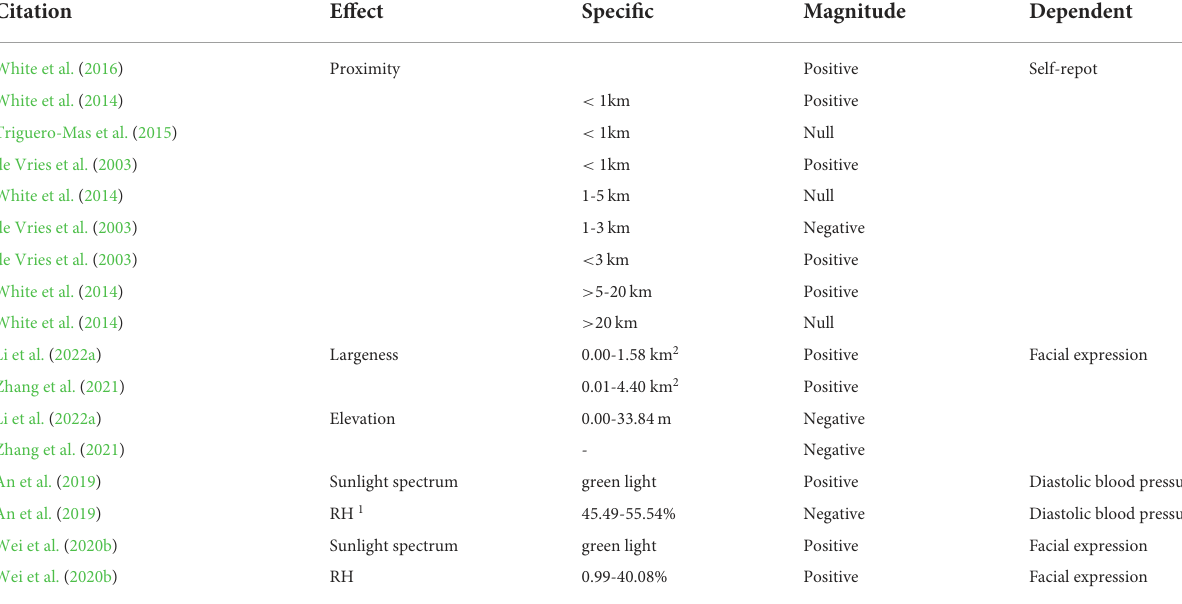
TABLE 1 Summary of emotional and psychological responses to experiences in blue spaces with varied metrics.